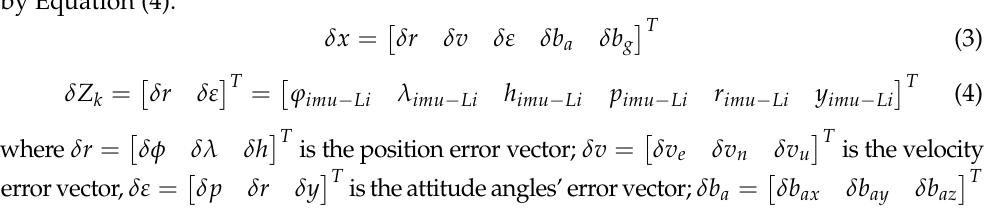
Figure 8. Graphical illustration of the data collection platform extrinsic transformation.